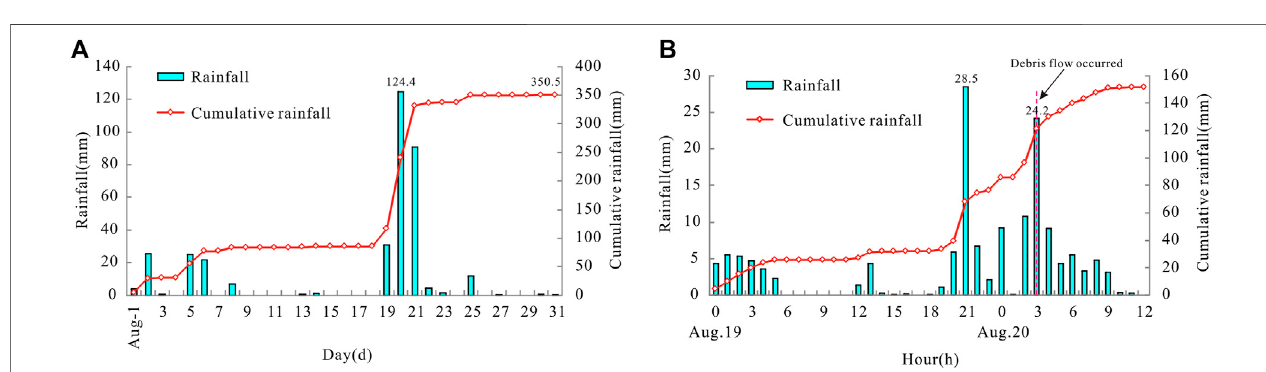
FIGURE 5 | Rainfall conditions in Wenchuan County: (A) rainfall conditions in Wenchuan County in August 2019; and (B) distribution of hourly and cumulative rainfall in Wenchuan County on August 19 – 20, 2019 (measured at the Dujiangyan Station).